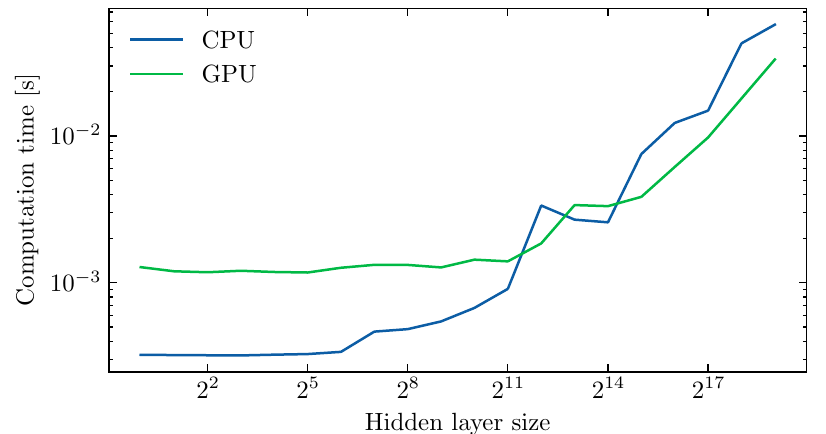
Figure 9. The average computation time of a fully connected network with 102 input neurons, a variable amount of hidden neurons, and one output neuron is only lower with GPU acceleration if the hidden layer has more than 2 11 hidden